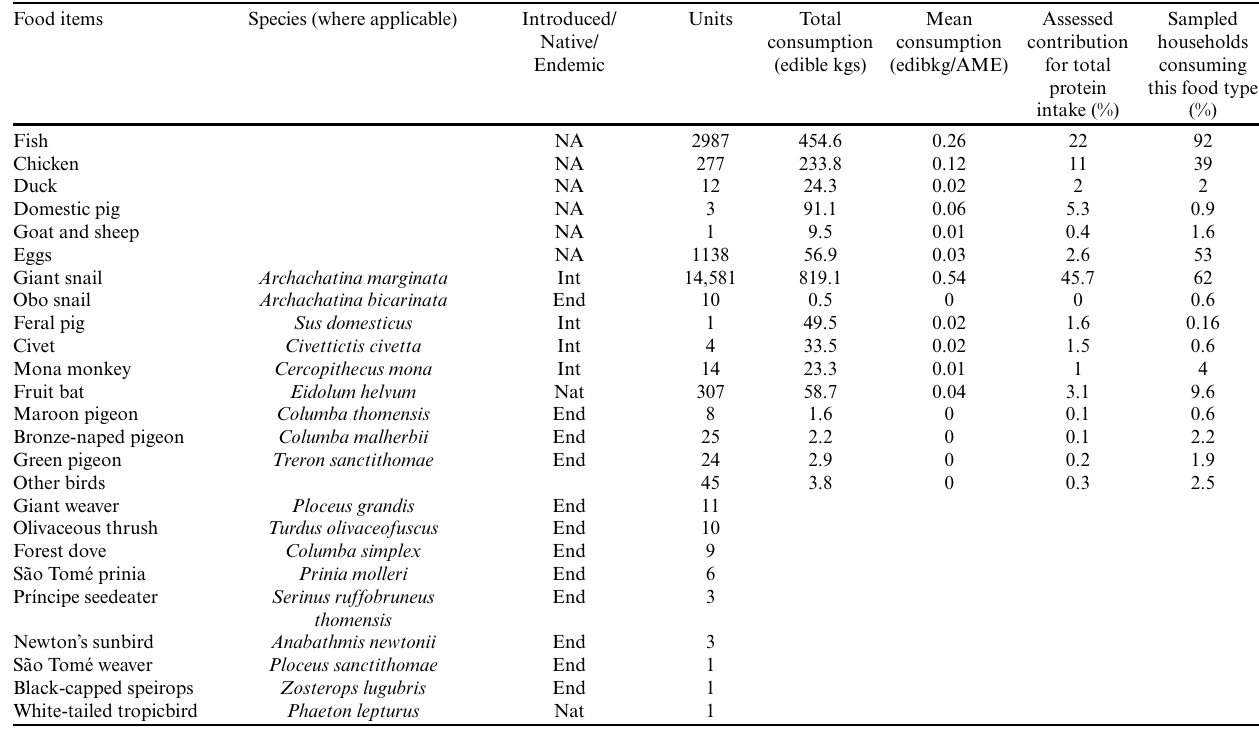
Table 1 . Animal food items and their relative consumption in sampled households (N = 195) in rural communities in São Tomé Island, corresponding to a sampling effort of 716 household weeks.